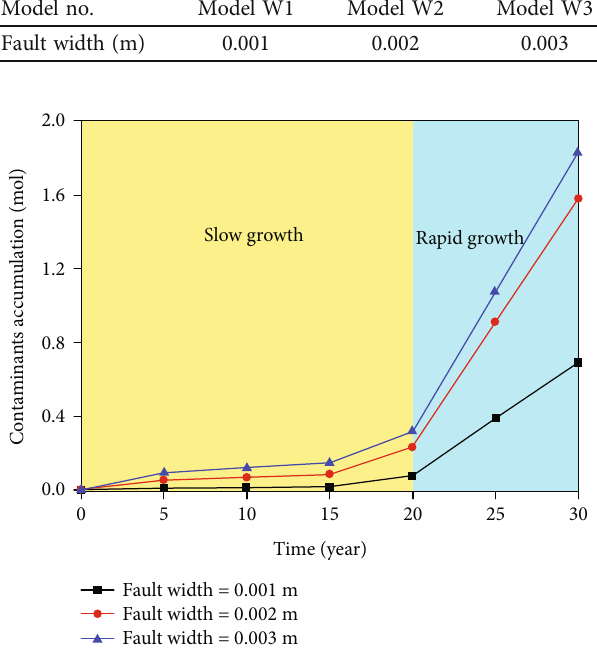
Figure 14: The contaminant accumulation along the line of CD under the di ff erent fault widths. Table 4: The fault dip angle in di ff erent models. Model